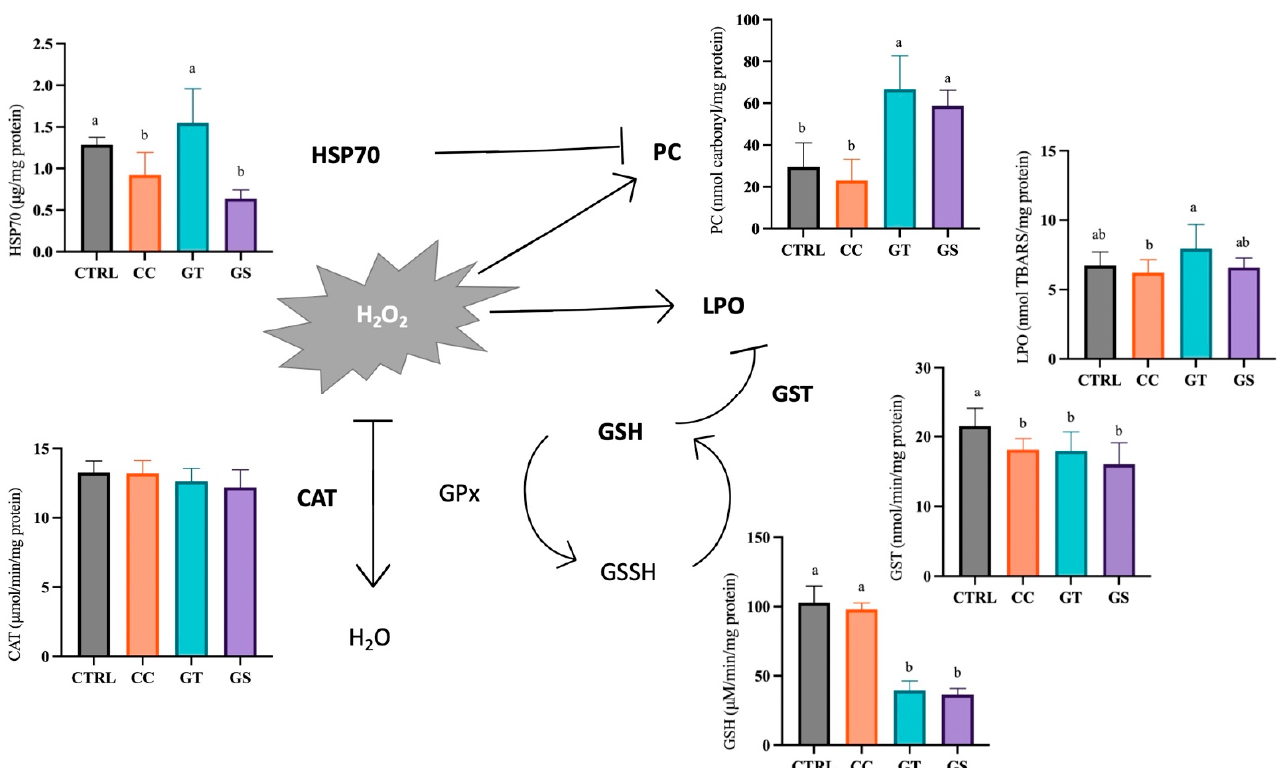
Figure 2. Schematic (simplistic) representation of the response and pathways of several oxidative stress-related biomarkers of 70 DAH Senegalese sole fed with different diets at the end of the growth trial (standard condition). Values are present as means ± SD. Different superscript letters indicate significant differences ( p < 0.05, 1-way ANOVA) between the dietary treatments.